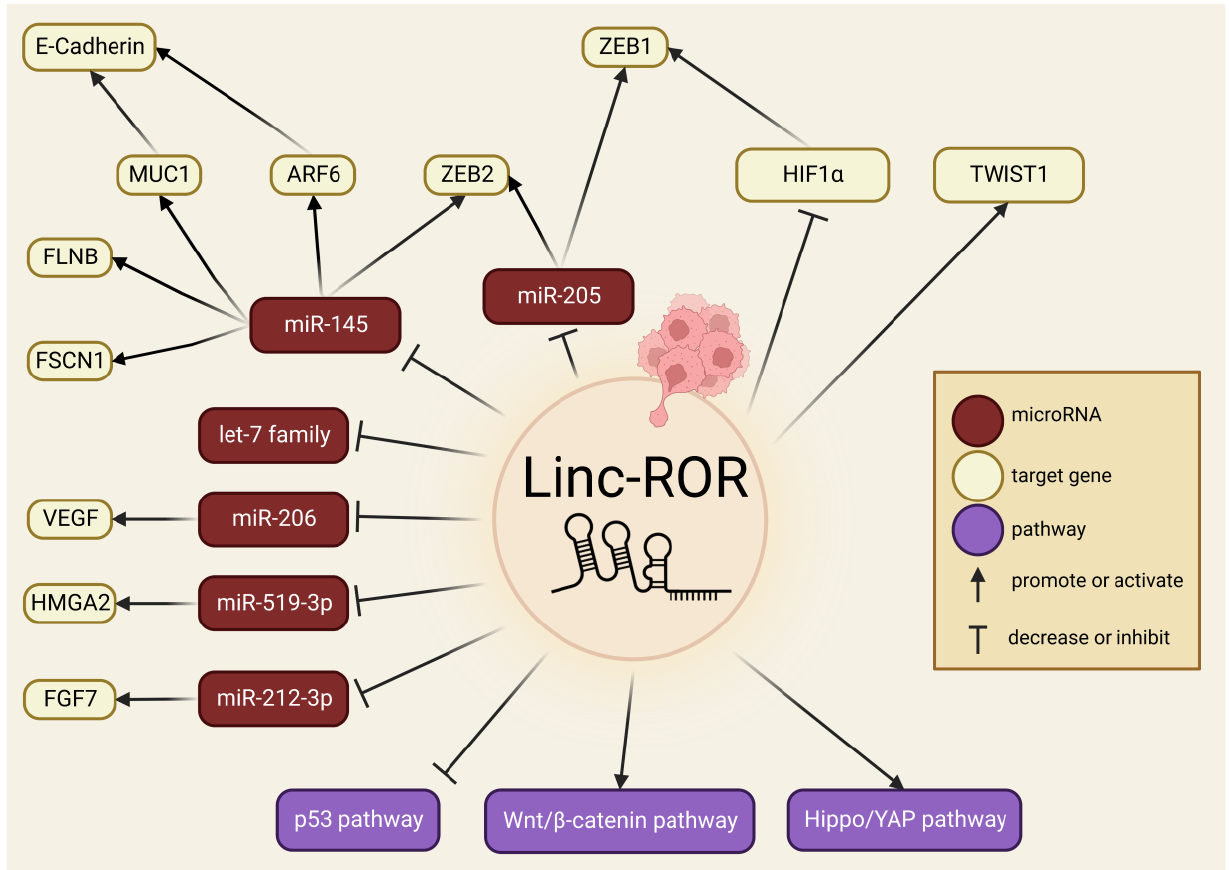
Figure 2. Overview of the molecular landscape by which linc-ROR participates in EMT, cancer invasion and metastasis.